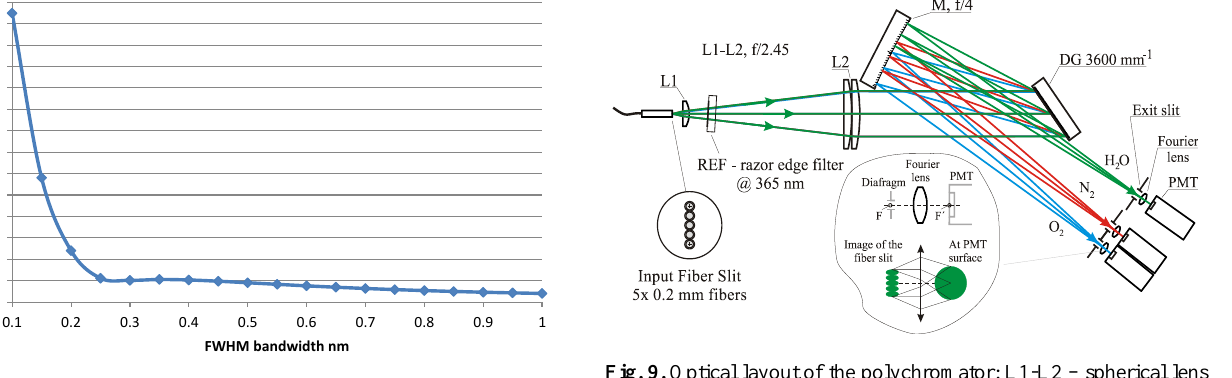
fiber core and external diameter and are, respectively,